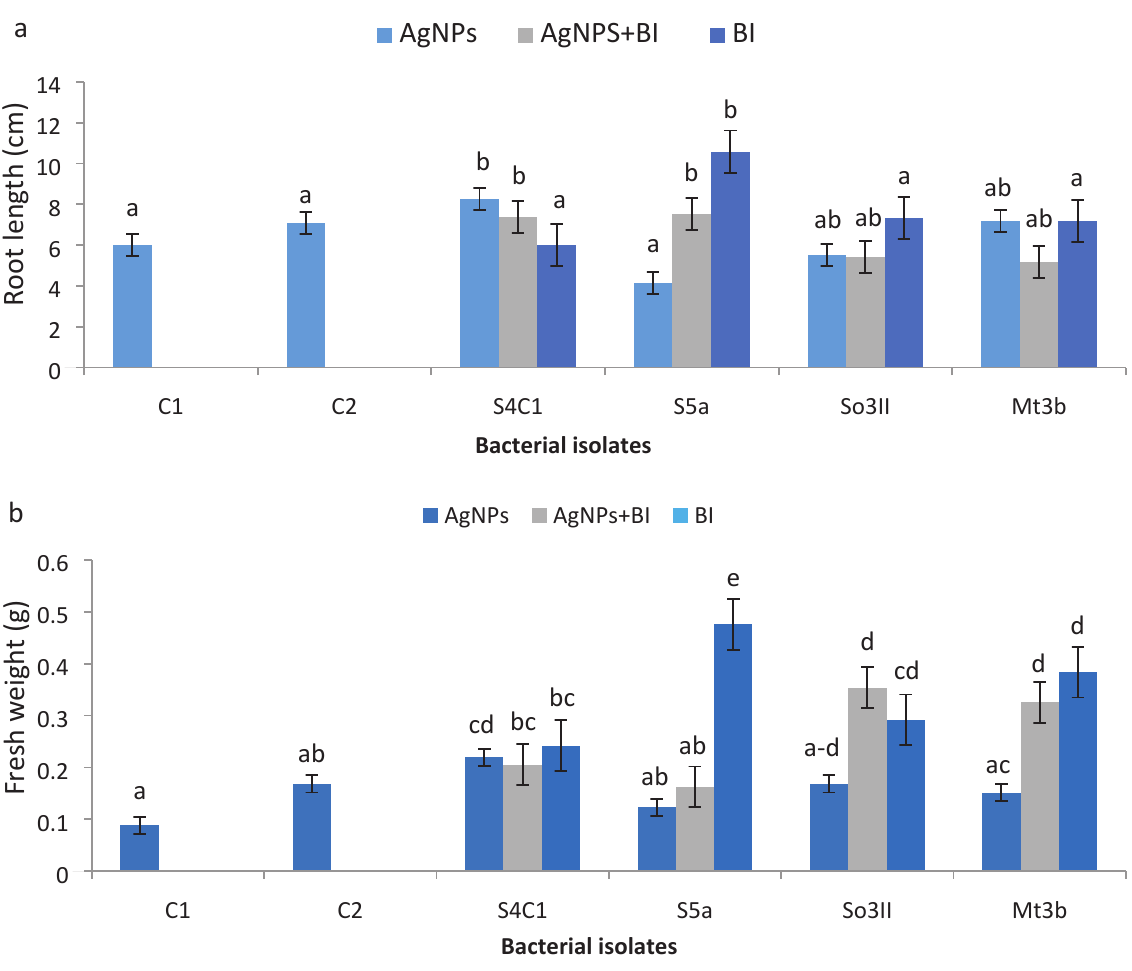
Figure 5: (a) Root length (cm); (b) Fresh weight (g) after inoculation treatment. T1 – bacterial AgNPs; T2 – bacterial AgNPs+BI; T3 – BI; C1 – Control treatment using water, C2 – Control treatment using AgNO3. Different letters indicate significant difference between treatments using Duncan’s multiple range test (P =